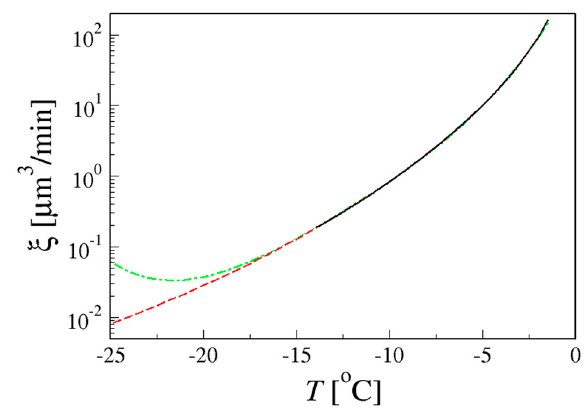
Figure 2 . Dimensional factor 𝜉 ( T ) appearing in the coarsening rate (black curve). The green dash-dot Figure 2. Dimensional factor ξ ( T ) appearing in the coarsening rate (black curve). The green dash-dot curve is the polynomial fit by Van Westen and Groot 23 and the red dashed curve is the present Padé curve is the polynomial fit by Van Westen and Groot [23] and the red dashed curve is the present fit. Pad é